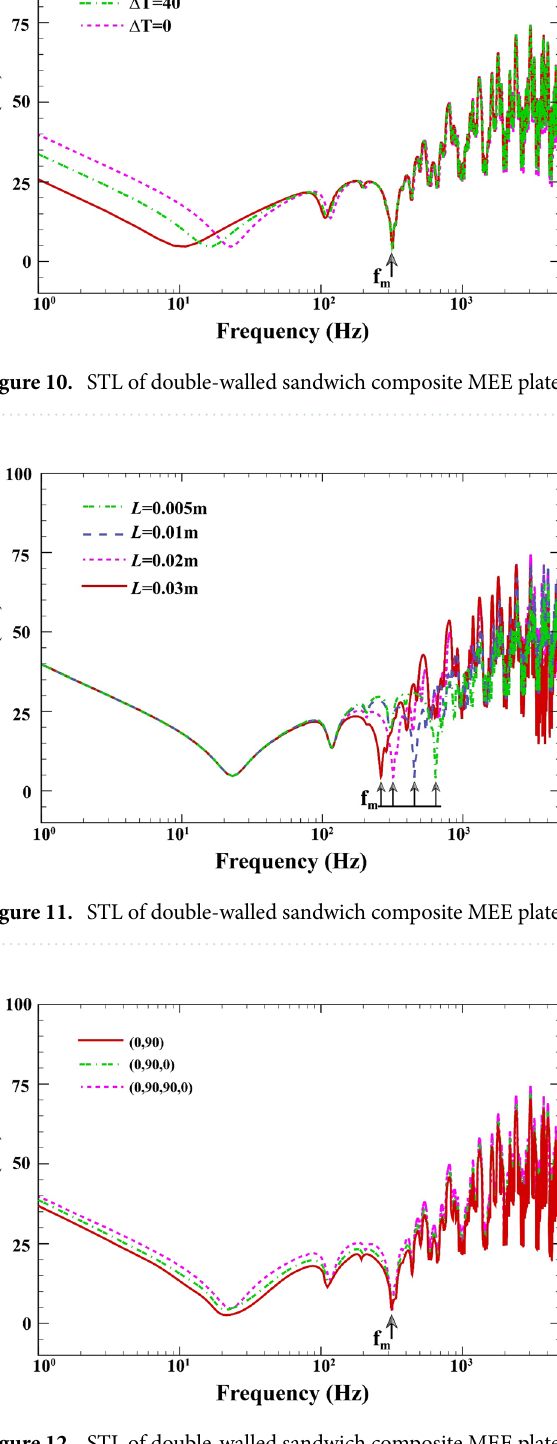
Figure 12. STL of double-walled sandwich composite MEE plate against the laminate